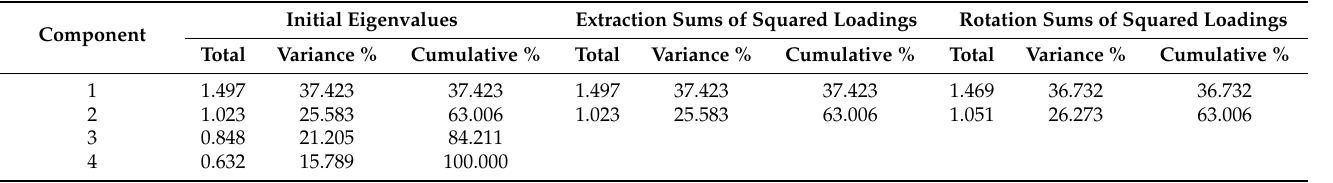
Table 4. Eigenvalues and variance explained with extracted factors of household economic capital (HEC). Component